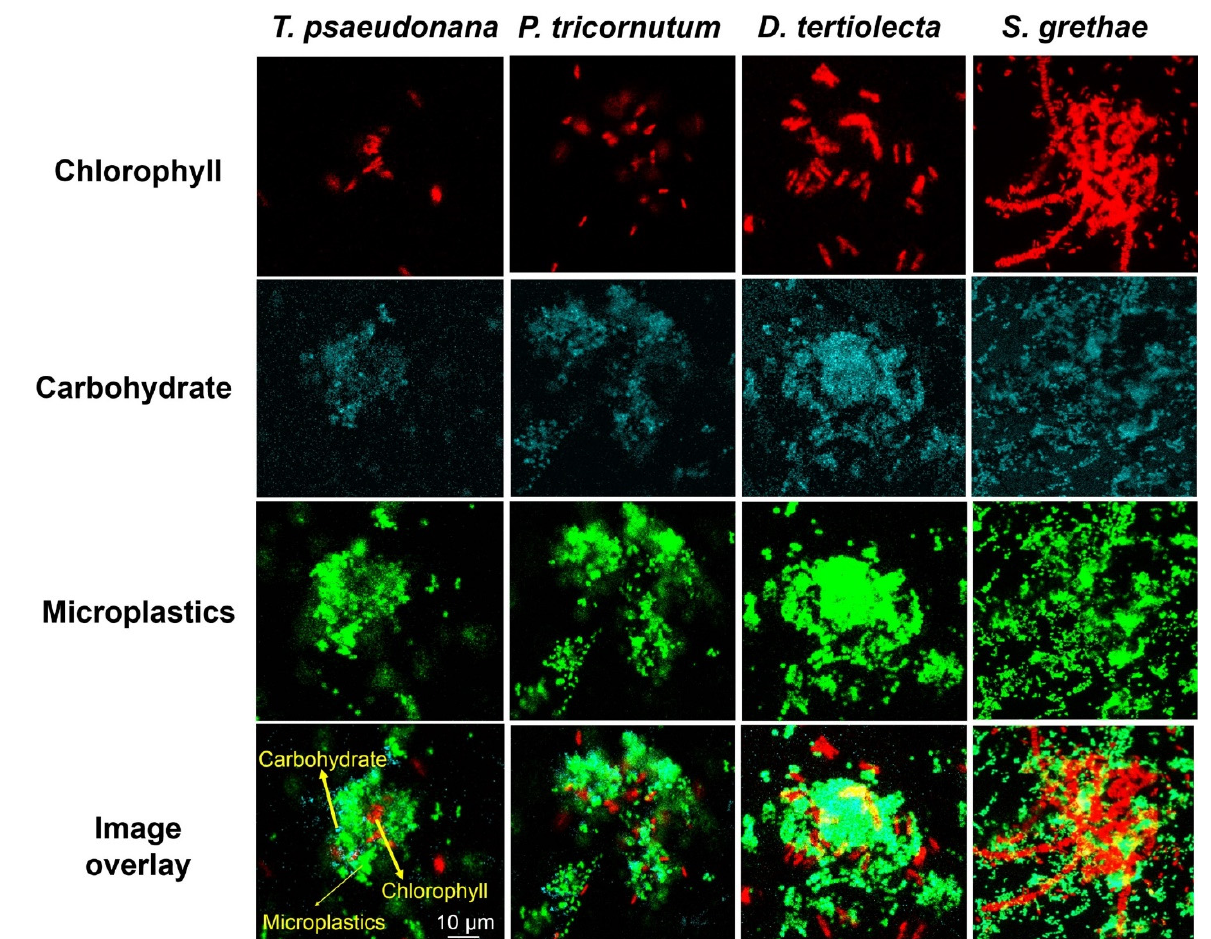
Figure 2. Marine Plastic Snow ( [19] , with permission from the publisher).